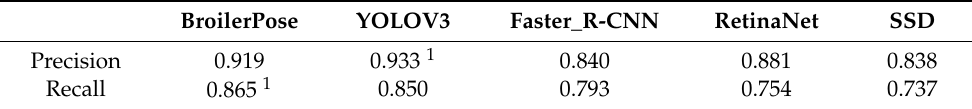
Table 3. Precision and recall of various